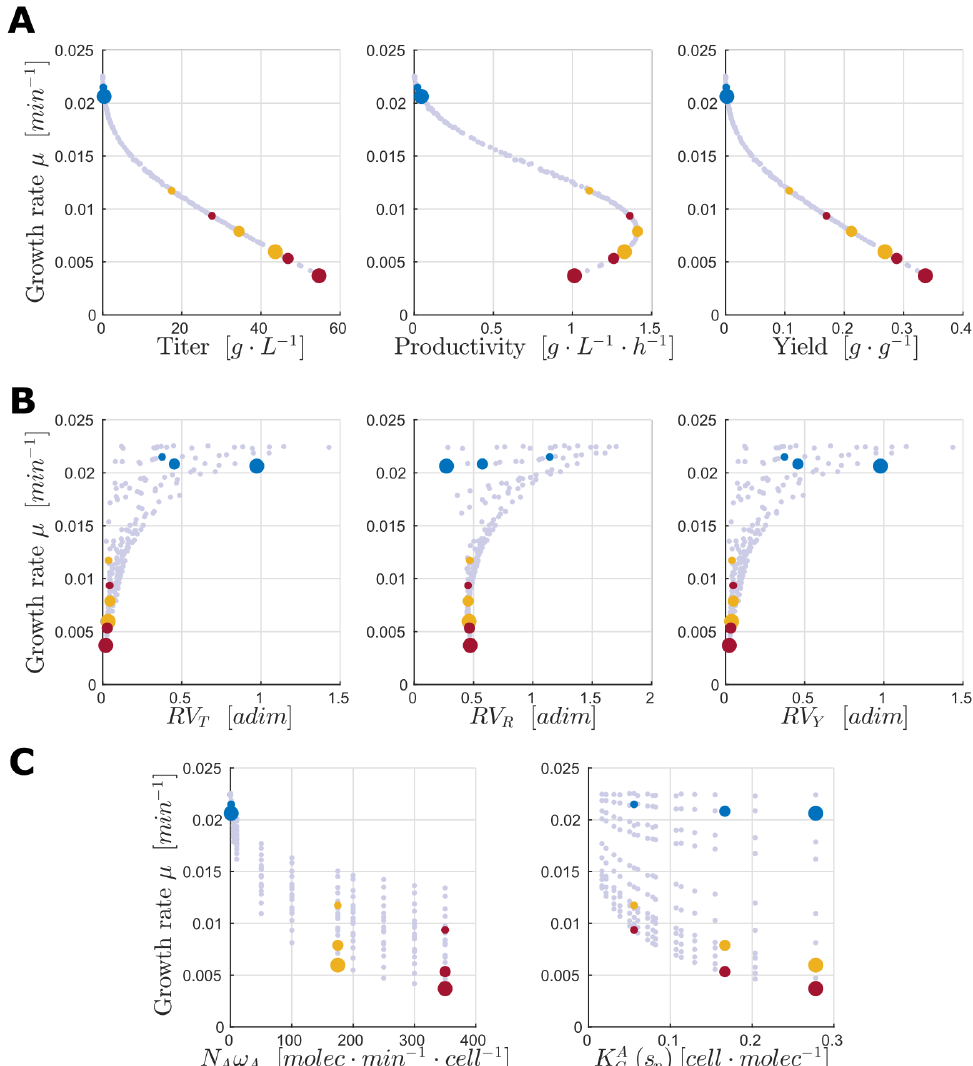
Figure 3. TRY values and relative variation indices of protein A for all the gene expression space in fed-batch operation obtained by simulation with the multi-scale model. All the plots share the growth rate as the y-axis. Each one dot corresponds to a different combination of transcription rate ( s n ) (note that we plot K A ( s n ) at nominal substrate s n = 3.6g · L − 1 , N A ω A and effective RBS K A C 0 C 0 ( s ) is not constant because s changes in simulation time). The colors blue, yellow and since K A C 0 red represent low, medium and high N A ω A respectively, while the sizes of the markers are small, ( s n ) . The gray color respresent the rest of medium and big and show low, medium and high K A C 0 ( s n ) combinations. ( A ) TRY measurements: titer, productivity and yield. ( B ) TRY N A ω A and K A C 0 relative variation indices for substrate variations. ( C ) Transcription rate N A ω A and the effective RBS ( s n ) strength K A C 0